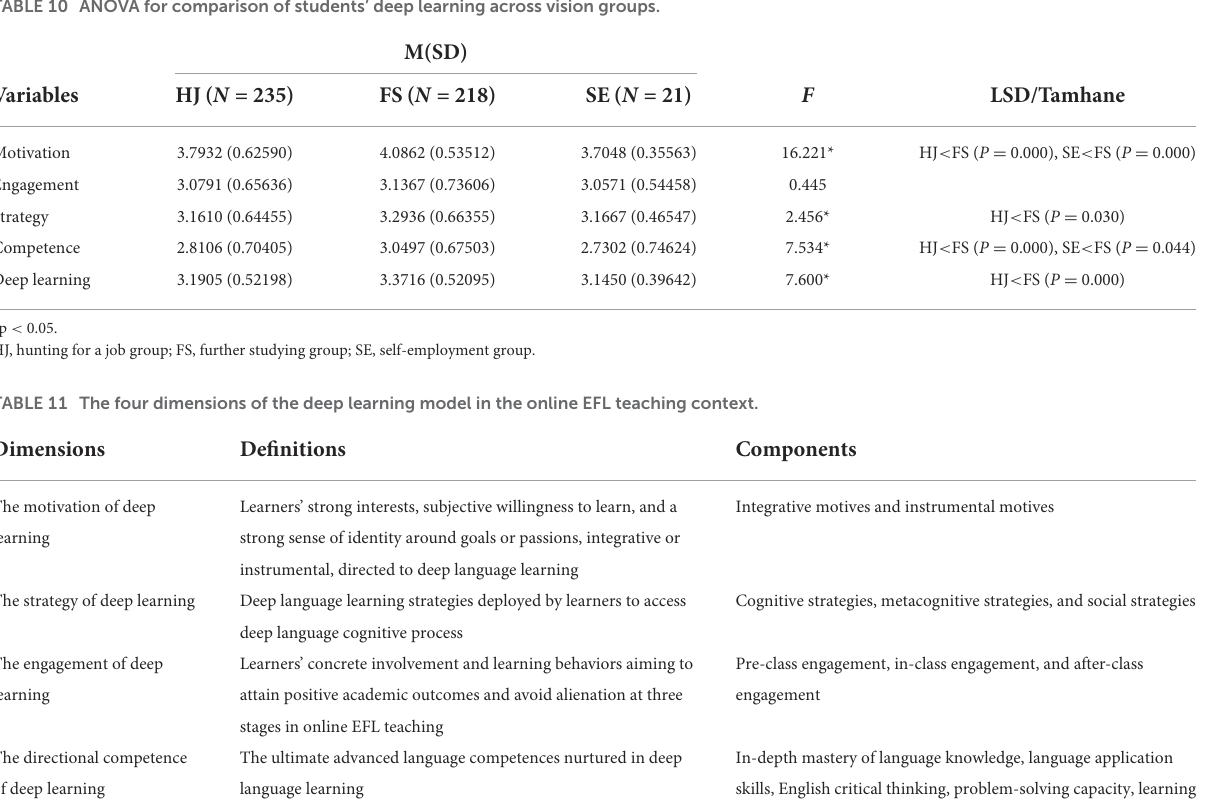
TABLE 10 ANOVA for comparison of students’ deep learning across vision groups.